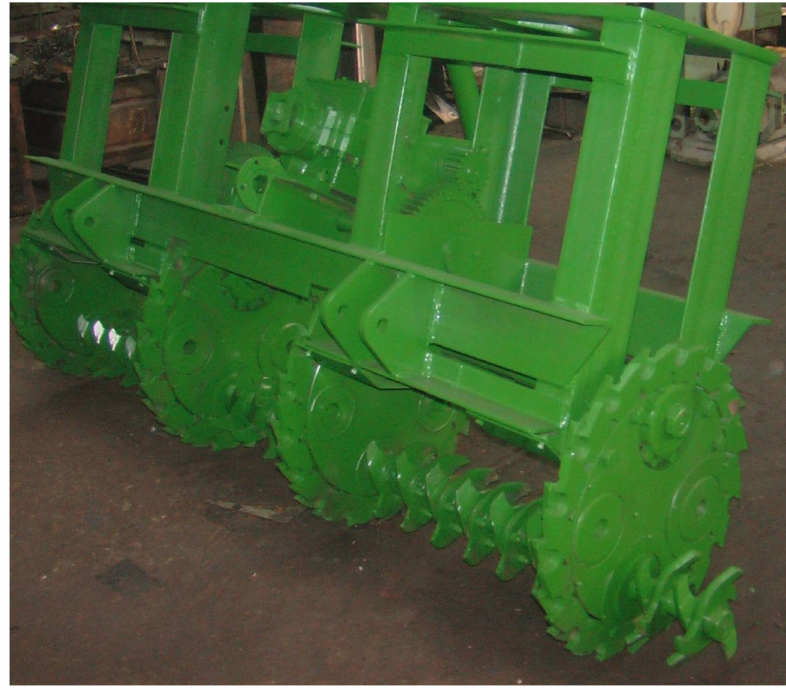
Figure 9. Intra-soil milling machine